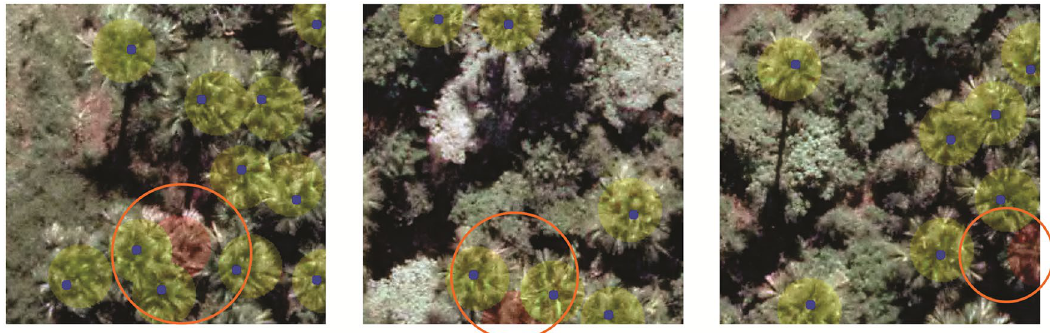
Figure 2. Examples of the challenges faced by our method in the M. flexuosa palm tree detection task. The orange circles indicate challenging detections.